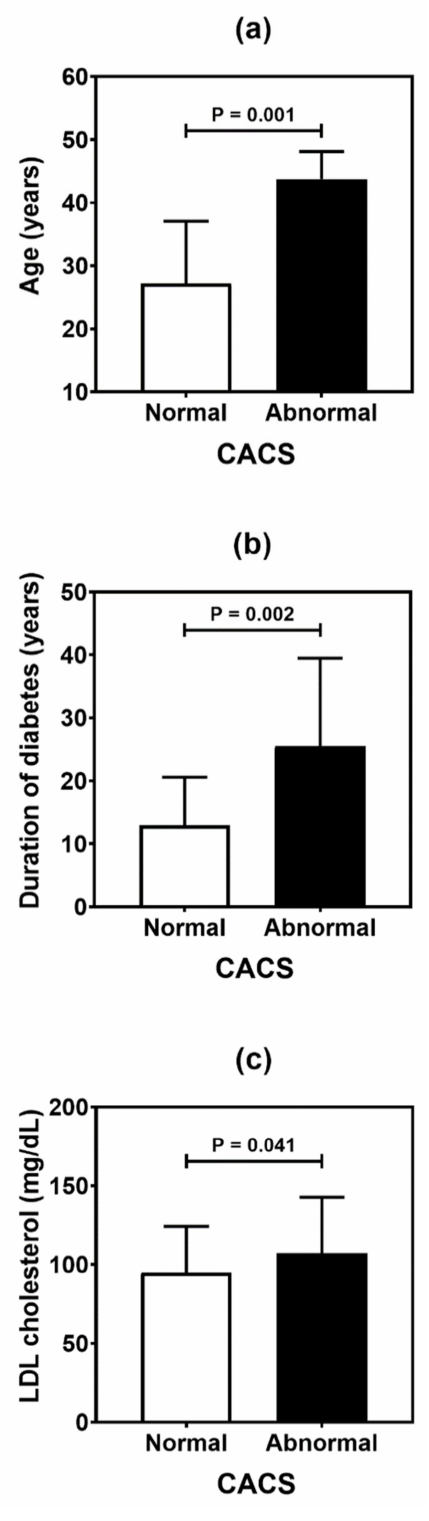
Figure 2. Comparative analysis of age ( a ), duration of diabetes ( b ), and LDL (low-density lipoprotein) cholesterol level ( c ) in type 1 diabetes patients according to the coronary artery calcium score (CACS). p values were determined by independent t